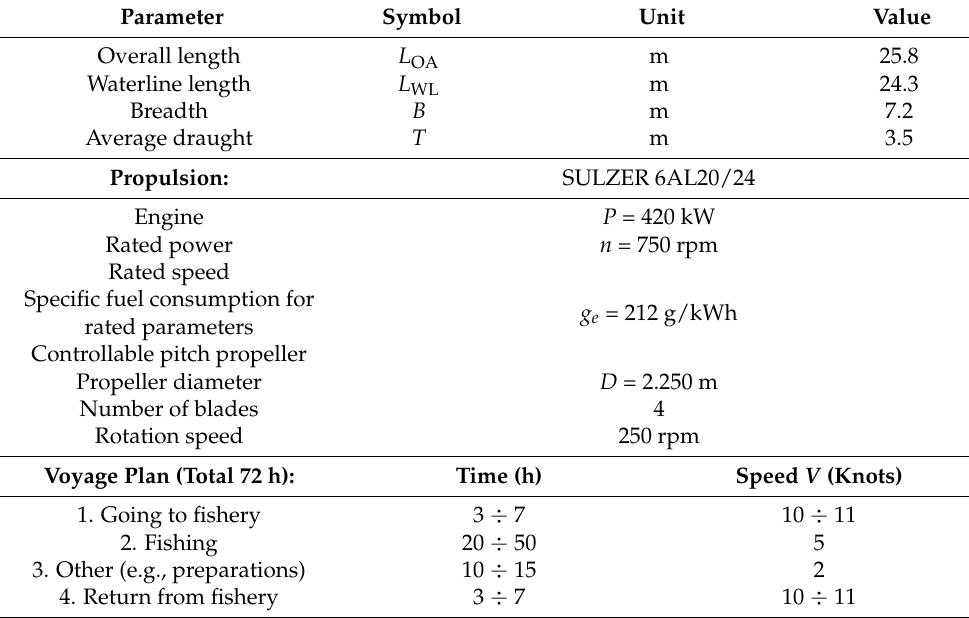
Figure 3. Modified hull of B-410 class ship with a O-shaped bulbous bow ( L B —length of bulbous bow measured from fore perpendicular as a percentage of length of waterline of the vessel, A BT —cross sectional area, h B —coordinate of the geometrical centre of the section measured from the base line, B B —section width, H B —section height). Table 1. Technical and operational parameters of B-410 class